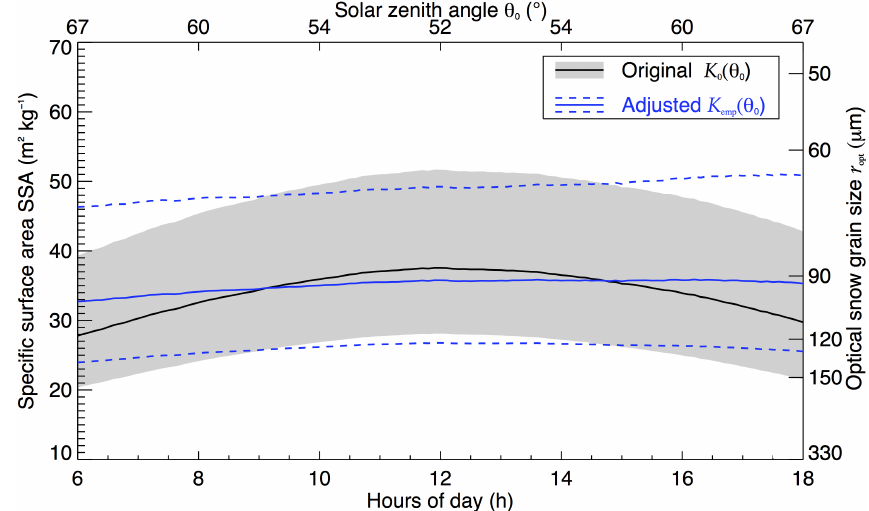
Figure 5. Diurnal cycle of SSA retrieved from CORAS measurements and optical snow grain size at Kohnen station on 24 December 2013. Black: SSA retrieved with original escape function K 0 (θ 0 ) (solid line) with retrieval uncertainty (shaded gray); blue: SSA retrieved with empirically adjusted escape function K emp (θ 0 ) (solid line) and retrieval uncertainty (dashed